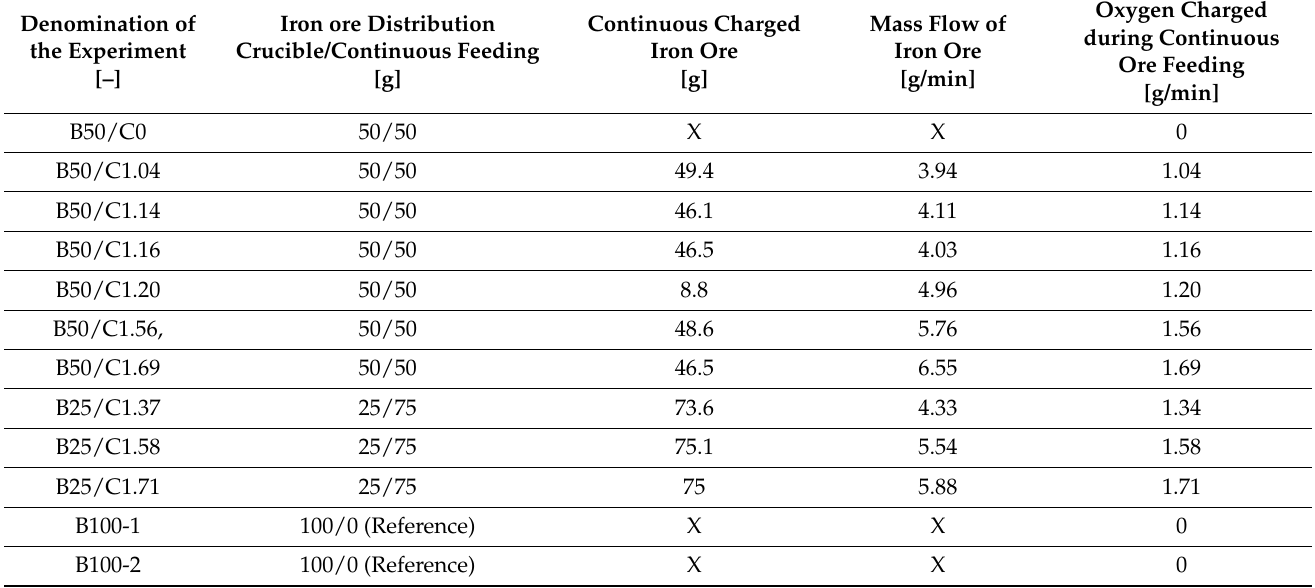
Table 2. Design of experiments of the trials at the HPSR laboratory facilities.